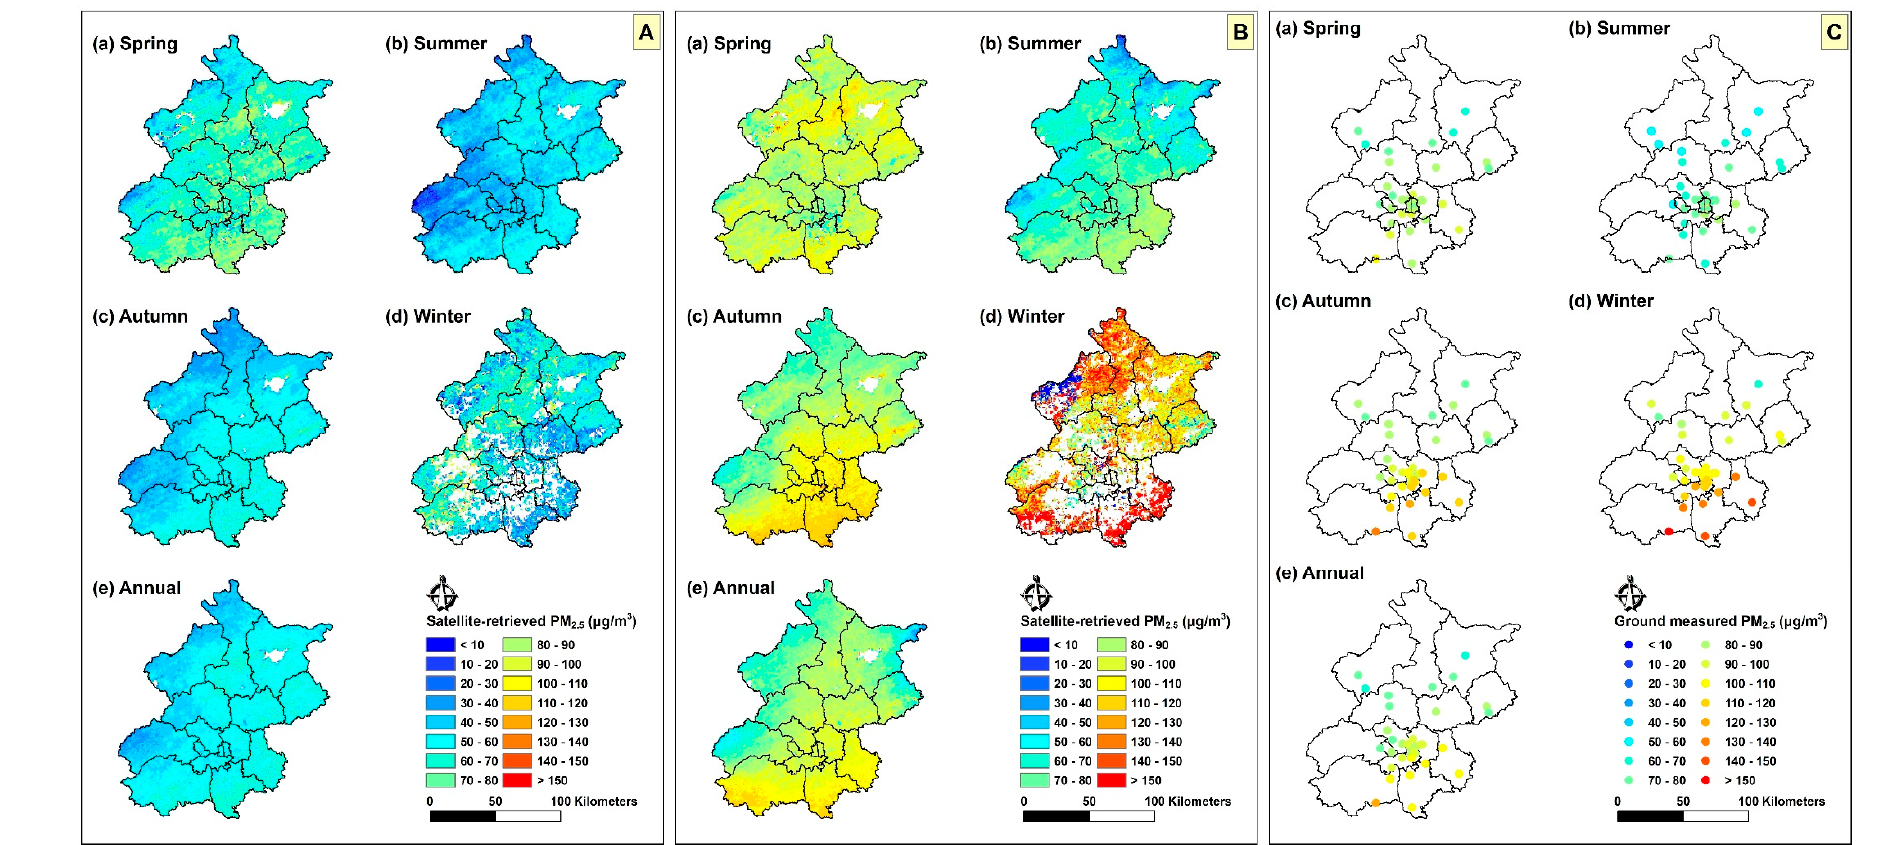
Figure 7. Seasonal-spatial distribution of ( A ) PM 2.5 predictions from the first-stage nested TFER model, ( B ) PM 2.5 predictions from the overall model, and ( C ) PM 2.5 observations. ( a – e ) all correspond to spring, summer, autumn, winter, and annual in subfigures ( A – C ).